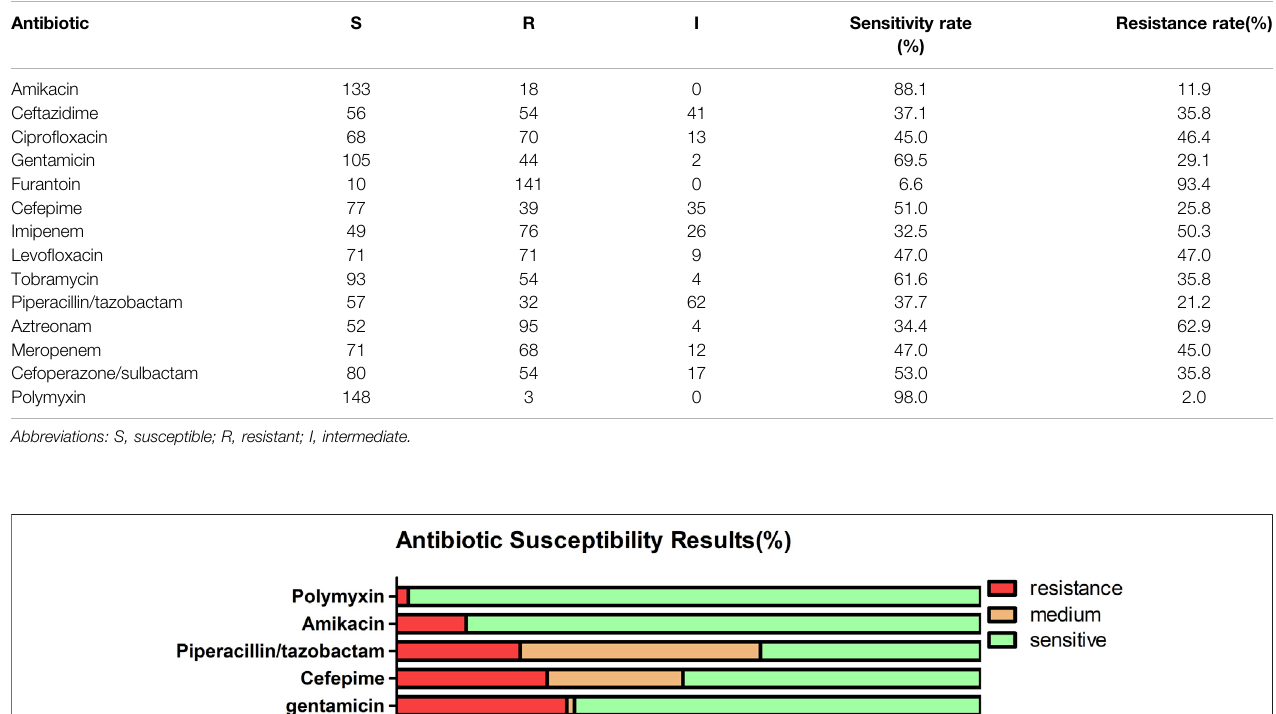
TABLE 2 | Antimicrobial resistance of the 151 isolates of P. aeruginosa to 14 antibiotics from 2017 to 2021 (%). Antibiotic S R